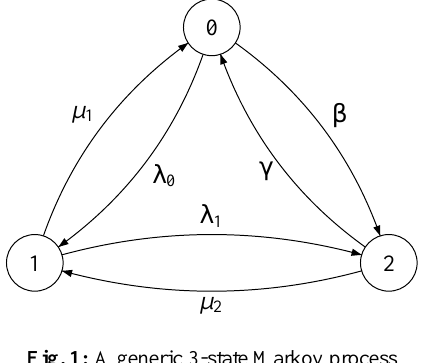
Fig. 1: A generic 3-state Markov